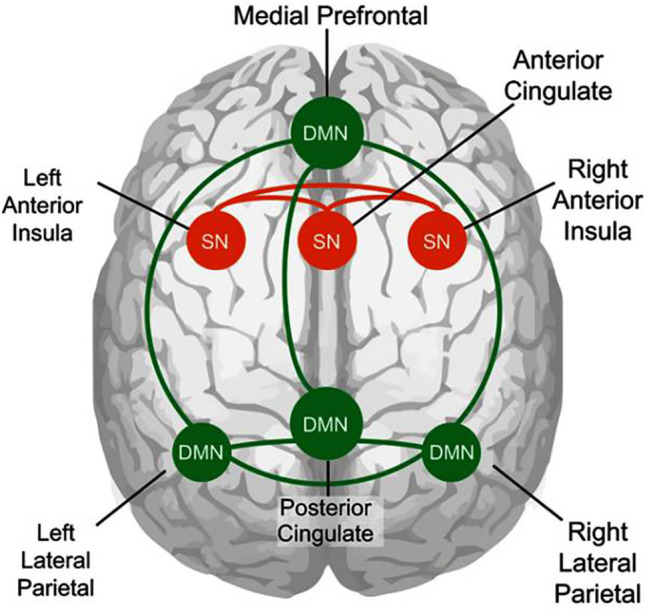
Node connections of the default mode network (DMN; shown in green) and the salience network (SN; shown in orange). Illustration of node connections used in this study. Adapted from van Ettinger-Veenstra et al. (2019).